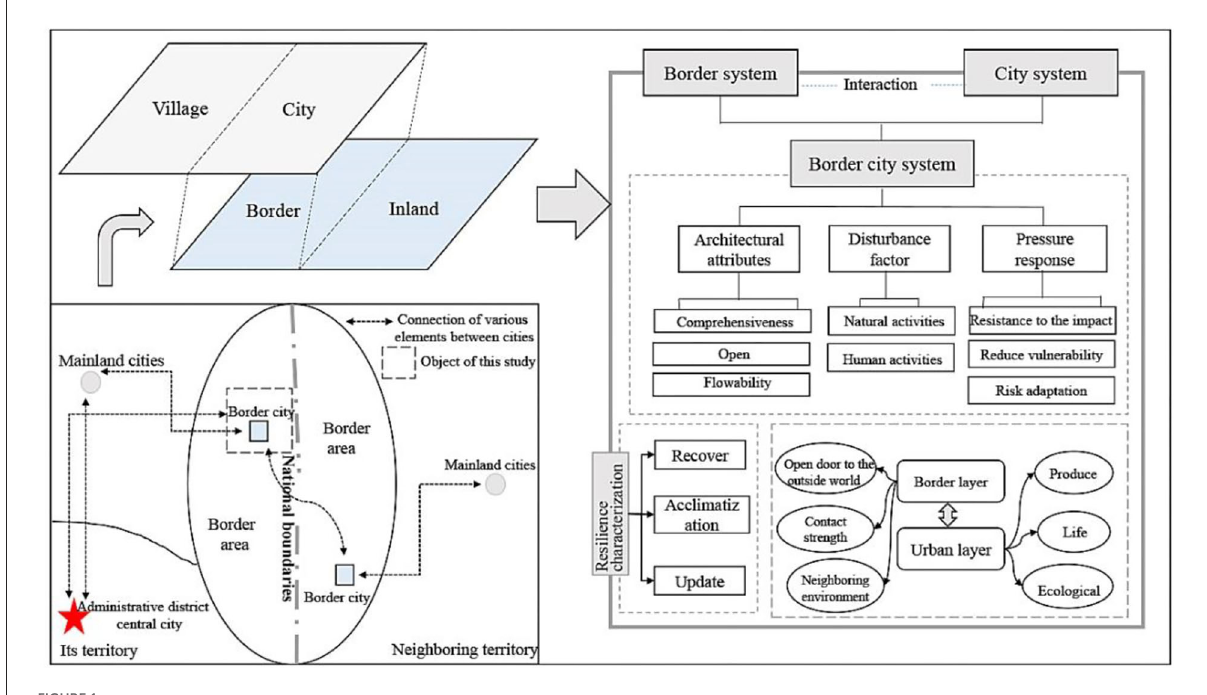
FIGURE1 Conceptual representation of border city